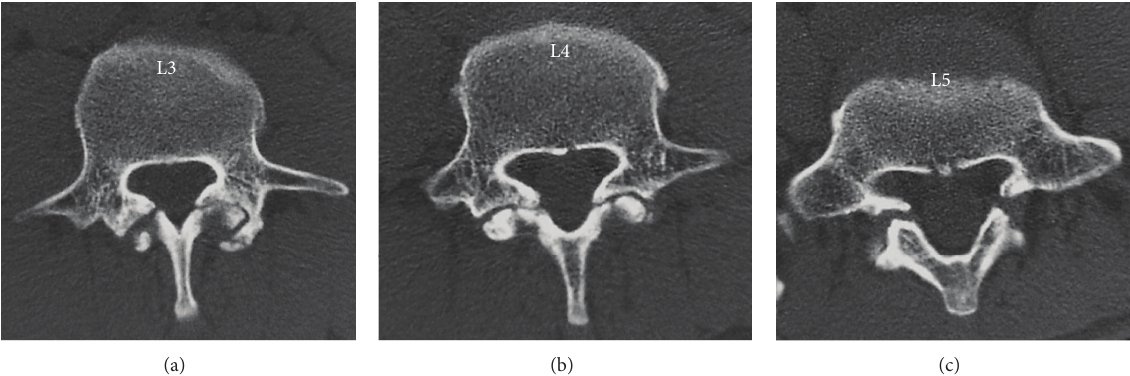
Figure 3: CT at initial presentation shows pseudarthrosis-type pars defects bilaterally at